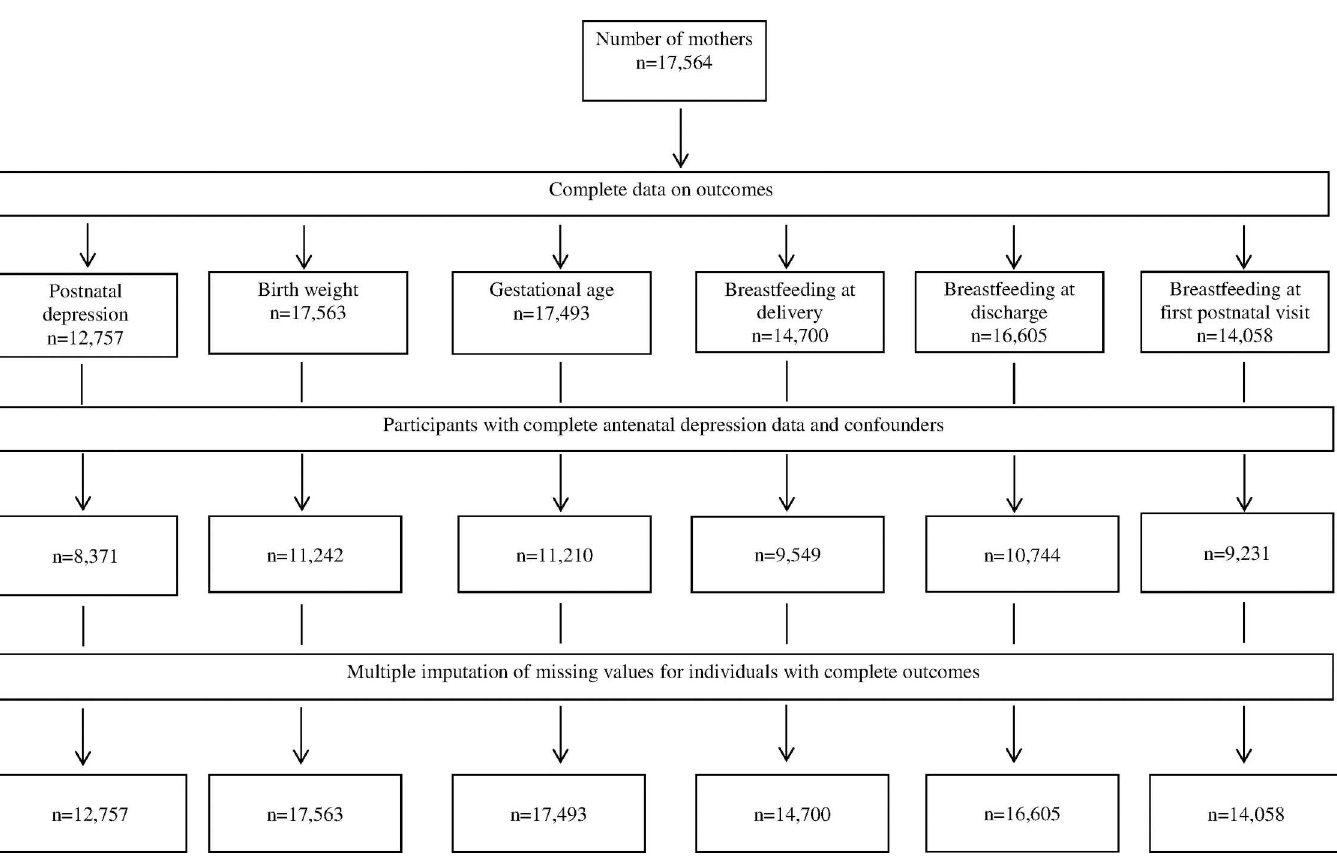
Fig 1. Flow chart of available data on postnatal depression, birth outcomes, and breast feeding behaviours of mothers of infants from South Western Sydney and Sydney Local Health Districts in 2014 (n =